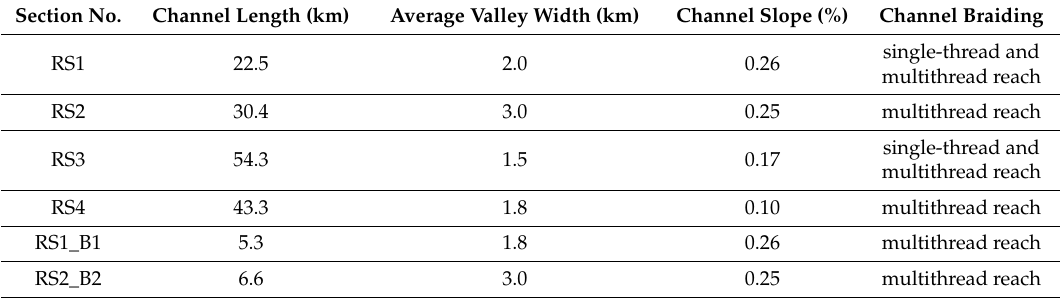
Table 1. Basic features of four reaches and two active focused areas in RS1 and RS2 below Zhikong Dam. Section